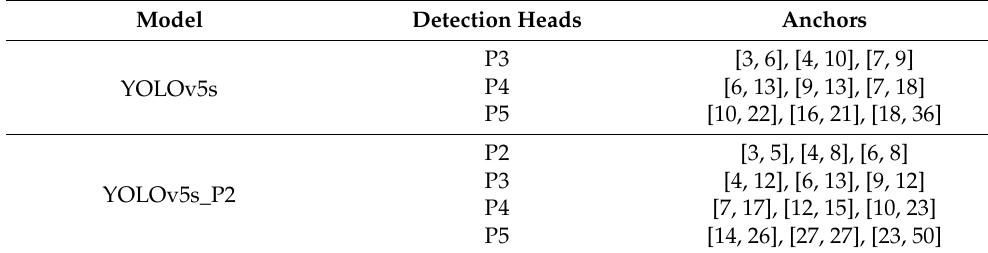
Table 1. Anchors obtained by clustering on the VisDrone